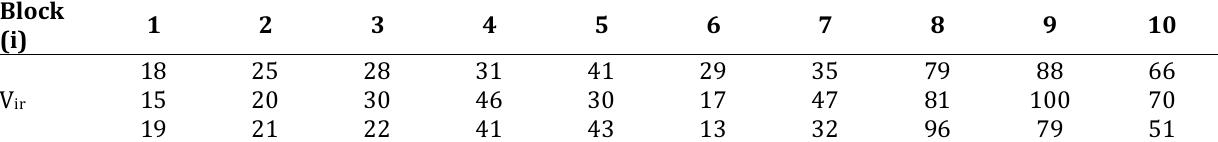
Table 6: Values of the inventory 𝑽